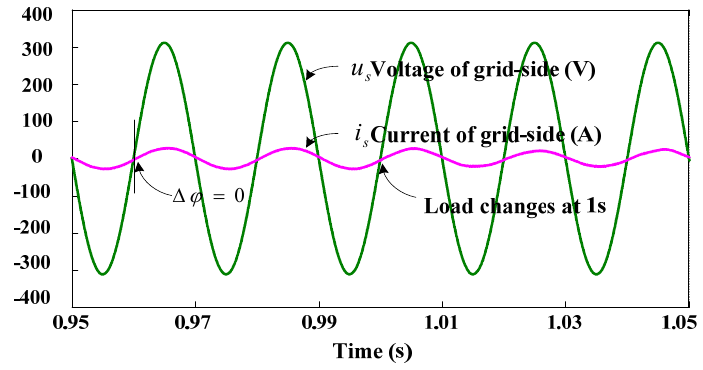
Figure 9. Control frame of system grid side converter.